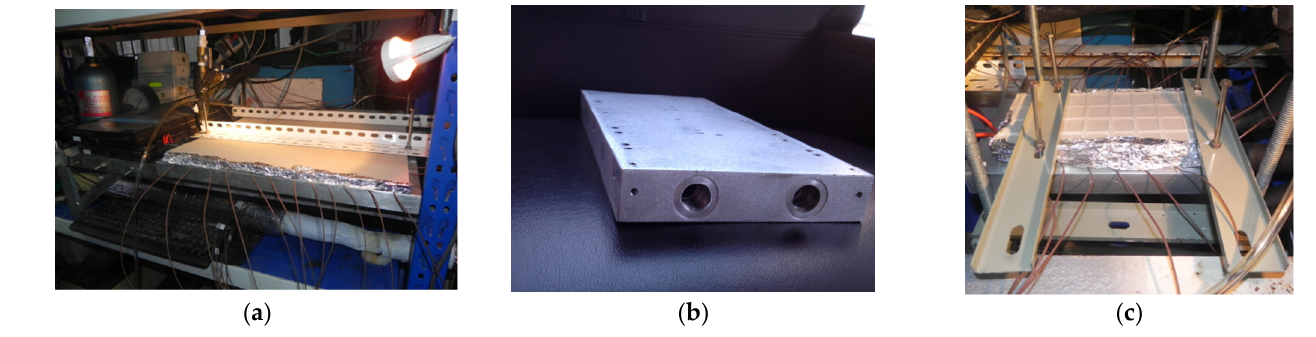
Figure 3. Photos of ( a ) experimental platform, ( b ) product of heat sink, and ( c ) test section rig. Table 3. Technical parameters of the Solartron IMP 3595 series.